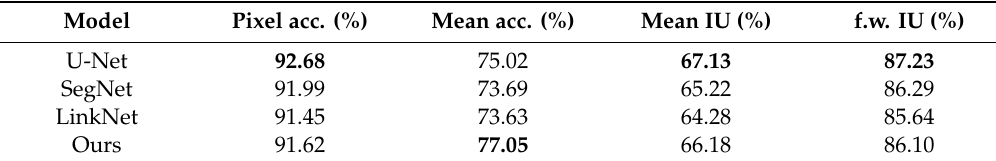
Table 4. Comparison of di ff erent architectures performance in dataset. (The best results are bold) Model Pixel acc. (%)